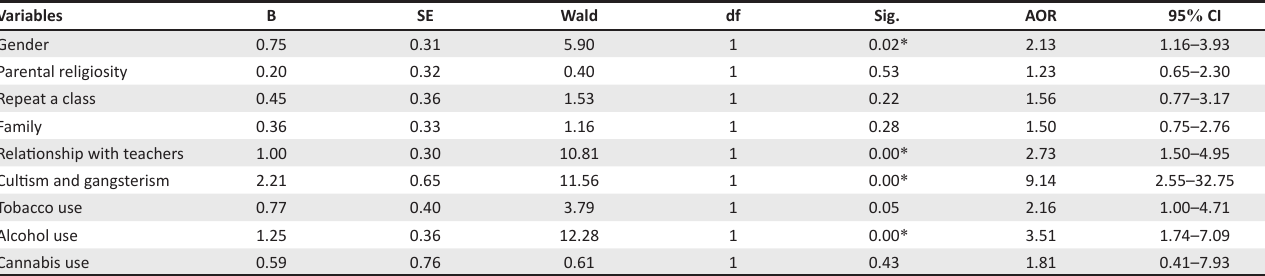
TABLE 3: Logistic regression of predictors of bullying.